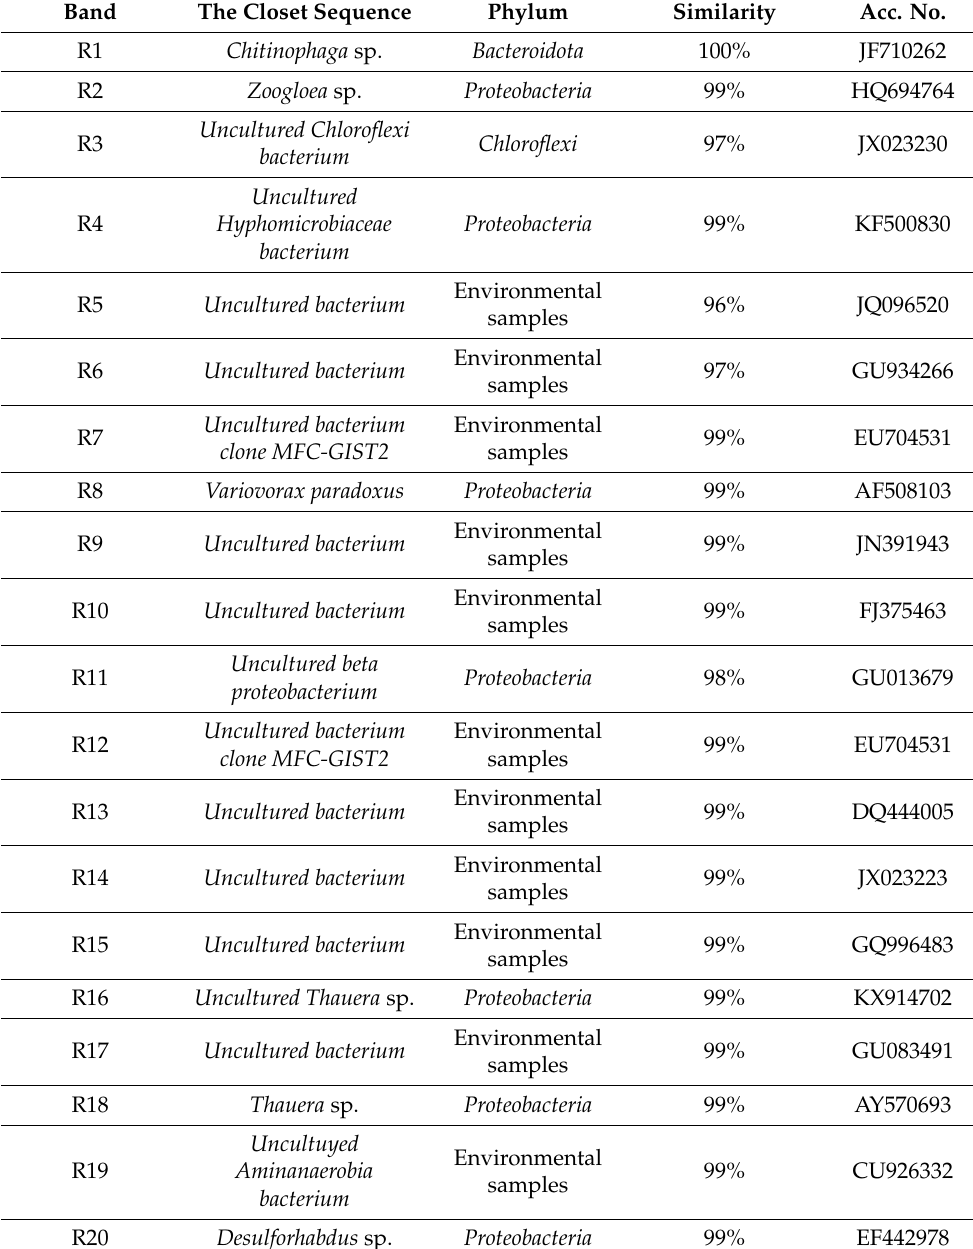
Table 3. Sequence analysis of DGGE bands for EBR using domestic WW. Band The Closet Sequence Phylum Similarity Acc. No. R1 Chitinophaga